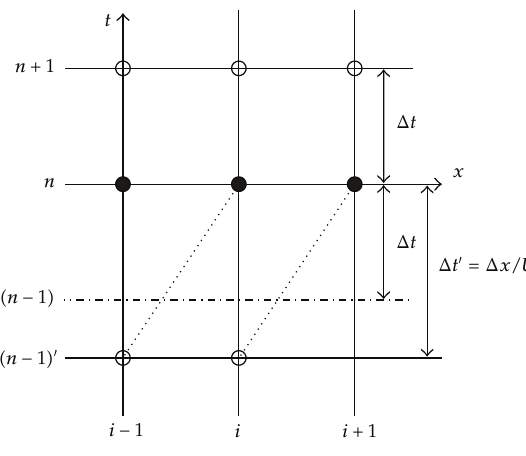
Figure 2: Estimation of concentration at a previous time